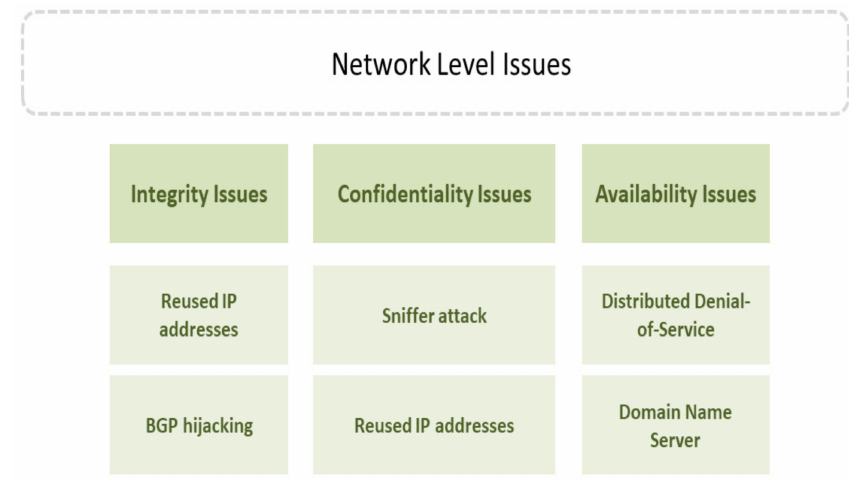
Figure 9. Network level